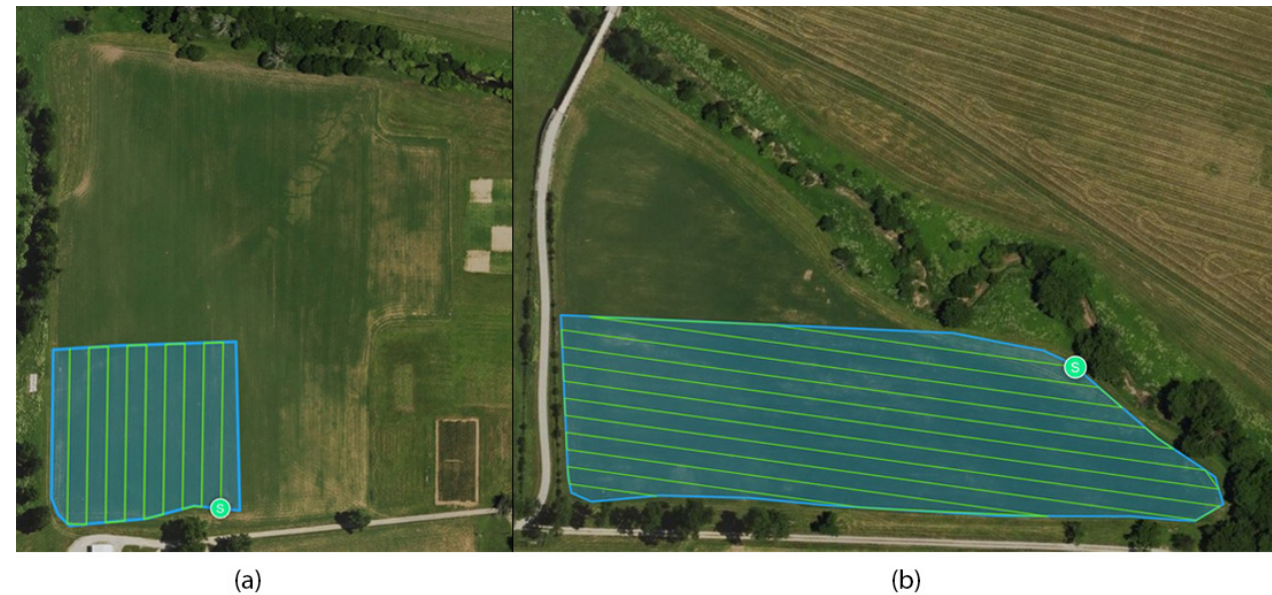
Figure 3. Field 1 ( a ) partial field layout with the route for the 50–90° flight parameters and Field 2 ( b ) partial field layout with the route for the 30–90° flight parameters. The “S” indicates the starting point of the mission.